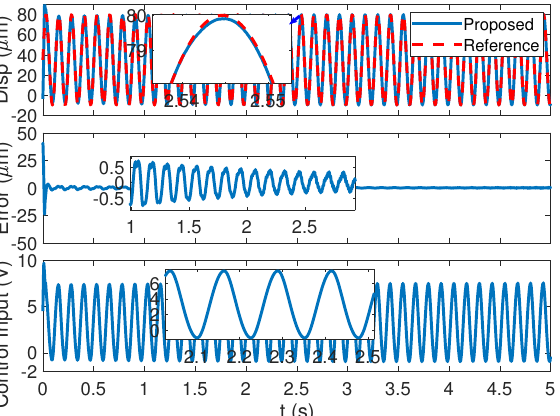
Figure 11. Experimental results of the sinusoid signal via the proposed algorithm (30 rad/s).